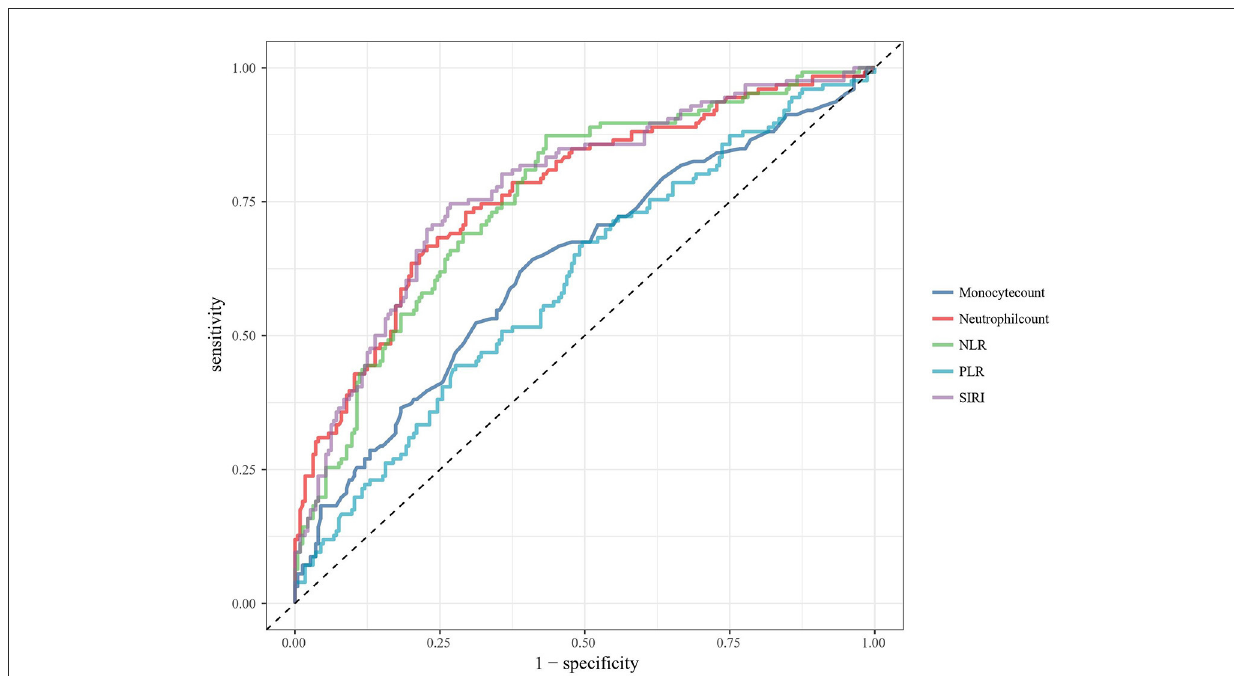
FIGURE2 ROC analysis of the association between biomarkers and functional outcome at 3 months after aSAH. ROC, receiver operating characteristic; aSAH, aneurysmal subarachnoid hemorrhage; NLR, neutrophil to lymphocyte ratio; PLR, platelet to lymphocyte ratio; SIRI, systemic inflammation response index.